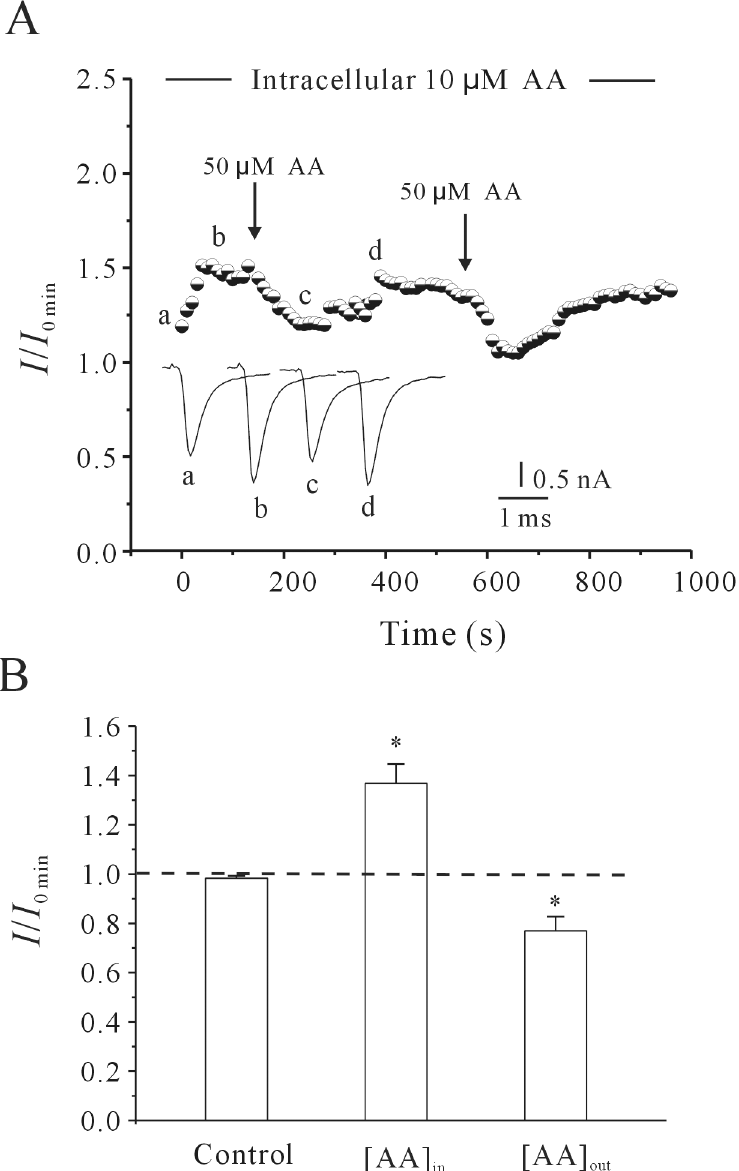
Fig 4. Effect of extracellular AA on the rNa V 1.4 current after intracellular application of AA. (A) Representative sample showing the time course of rNa V 1.4 current amplitude under control conditions, after intracellular application of 10 μ M AA, and after extracellular application of 50 μ M AA. The letters (a, b, c and d) noted on the curves correspond to the superimposed rNa V 1.4 current traces in the insets. I 0 denotes the current obtained at membrane rupture. (B) Statistical analysis of the effect of internal AA ([AA] in ) and external AA ([AA] out ) on the amplitude of rNa V 1.4 current. * , P < 0.01 compared to control, using the Student ’ s t